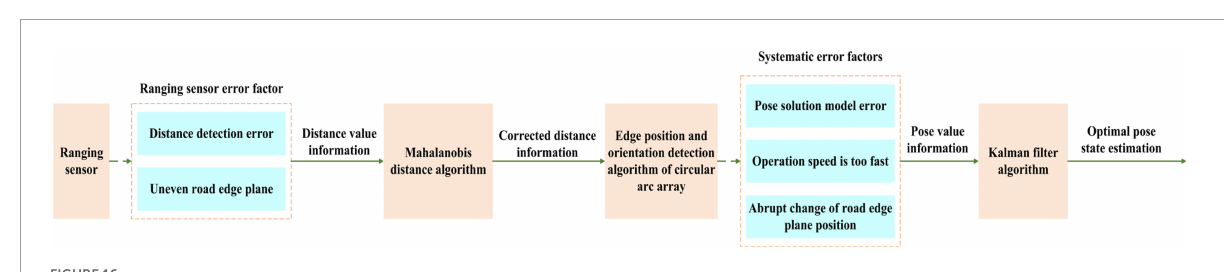
FIGURE16 Multi-factor detection error compensation and a weakening scheme for an edge-relative